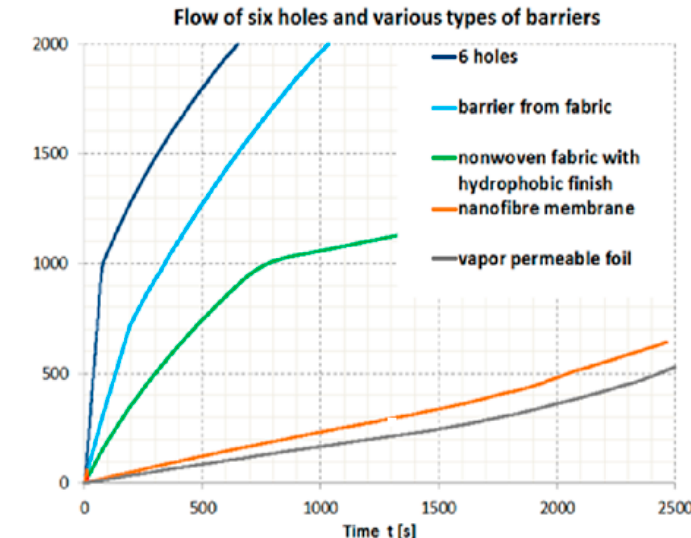
Figure 4. Flow rate through a test container with six openings and different types of barriers.